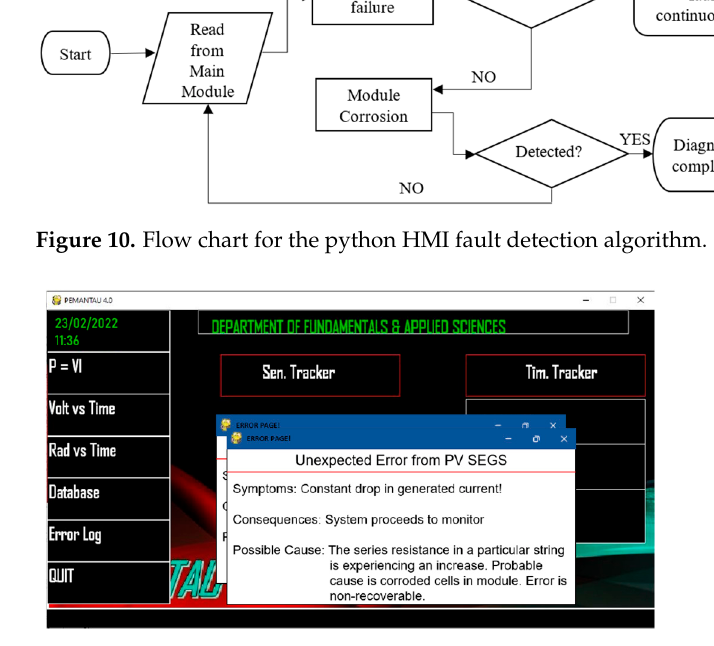
Figure 11. HMI screen message for module corrosion.